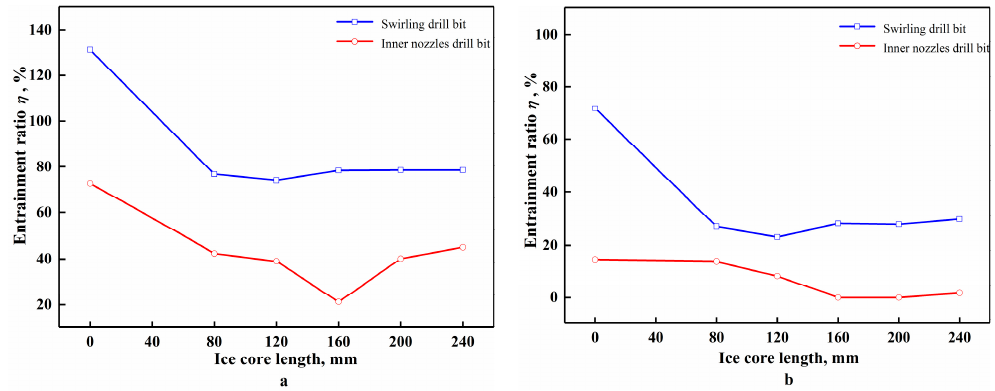
Figure 13. Comparison of entrainment ratio between swirling drill bit and normal drill bit: ( a ) drill bits without flushing nozzles; ( b ) drill bits with flushing nozzles.